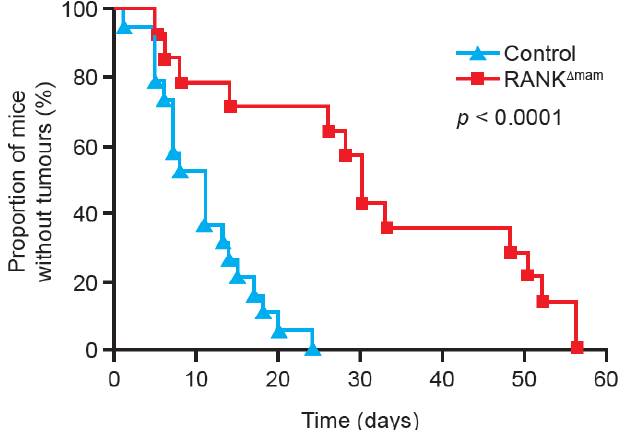
Figure 4. RANK knock-out from mammary gland epithelia inhibits tumour formation. Tumour growth following the administration of the carcinogen DMBA and the progesterone derivative MPA in mice with inactivated mammary gland epithelial cell RANK expression (RANK Δ mam ) and in wild-type mice (control) [31]. Reprinted from